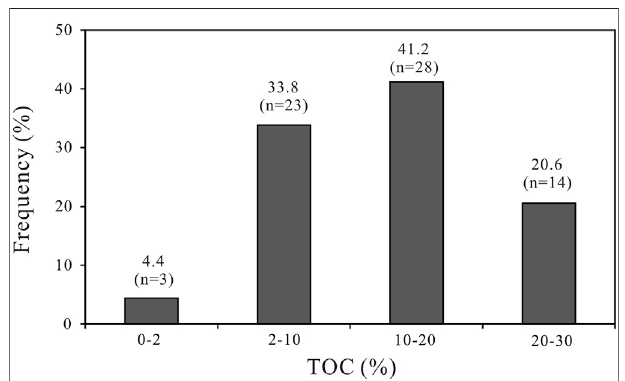
FIGURE5| FrequencydistributionofTOCcontentsintheChang7black shale of Yanchang Formation, Ordos Basin.